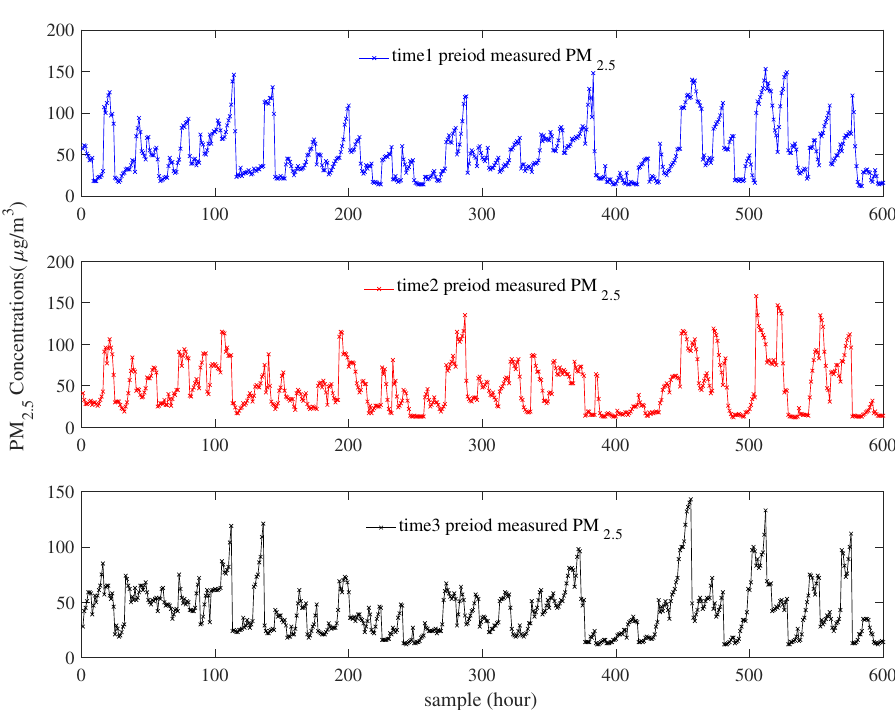
Figure 5. The modeling data of PM 2.5 concentration in three time periods. The obtained PM 2.5 concentration prediction values from different time periods are fused by Bayesian method. The proposed MMAUKF method is implemented to predict PM 2.5 concentration. The structure chart of MMAUKF method is shown as follows: